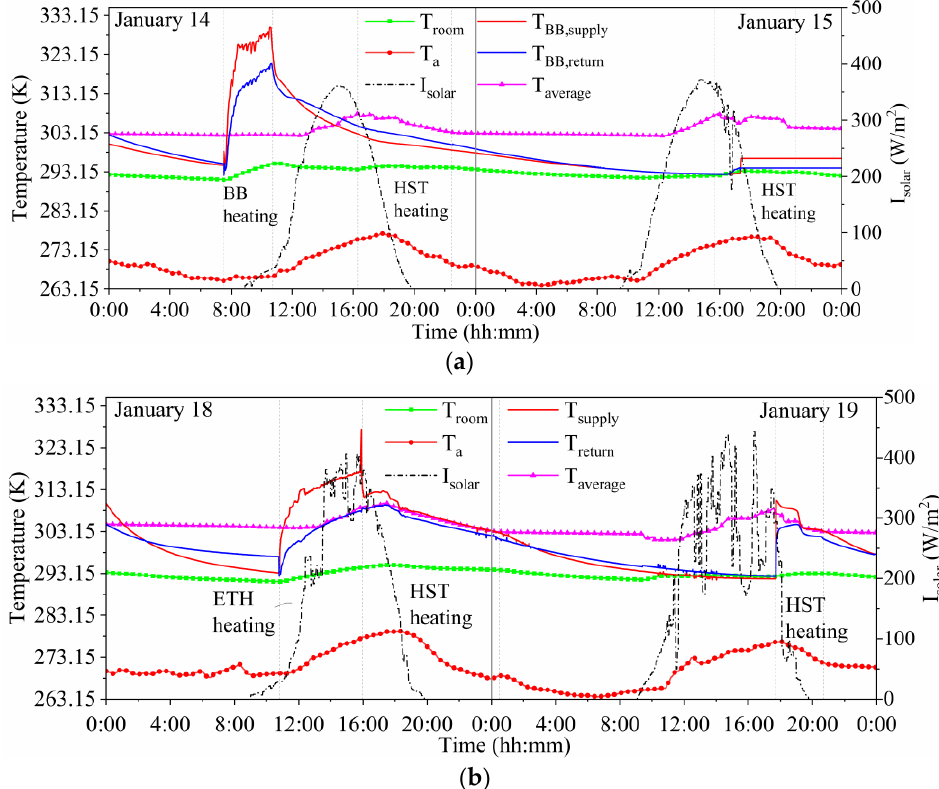
Figure 5. Experimental test data: ( a ) Mode 3 and ( b ) Mode 4.